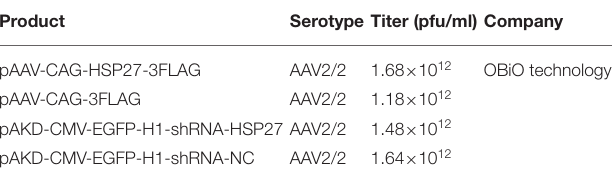
TABLE 2 | Adeno-associated virus (AAV).